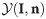
Summations in the sampling formula for a population with multiple fitness states.Illustration of summations over Y(I,n) and Y(n) in Eqs 31 and 32 respectively, for a list of allelic counts n = {4, 1, 2}. (A) The finite plane case. Finite plane capacities are shown in parentheses. (B) The infinite plane case.